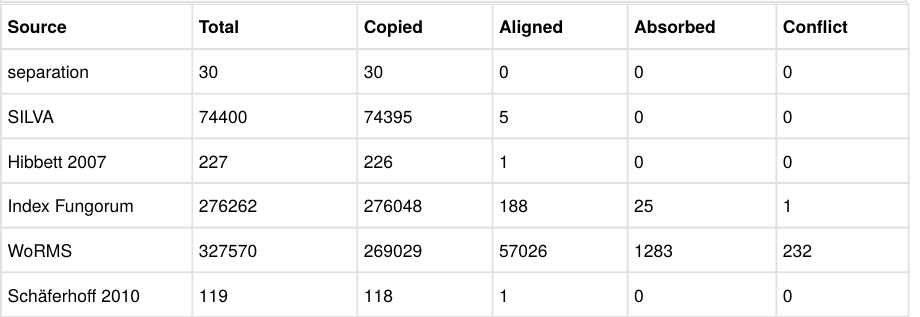
Fate of source nodes from each of the input taxonomies. Unaligned nodes are either copied into the workspace or absorbed. Aligned nodes are added to the workspace through grafting or